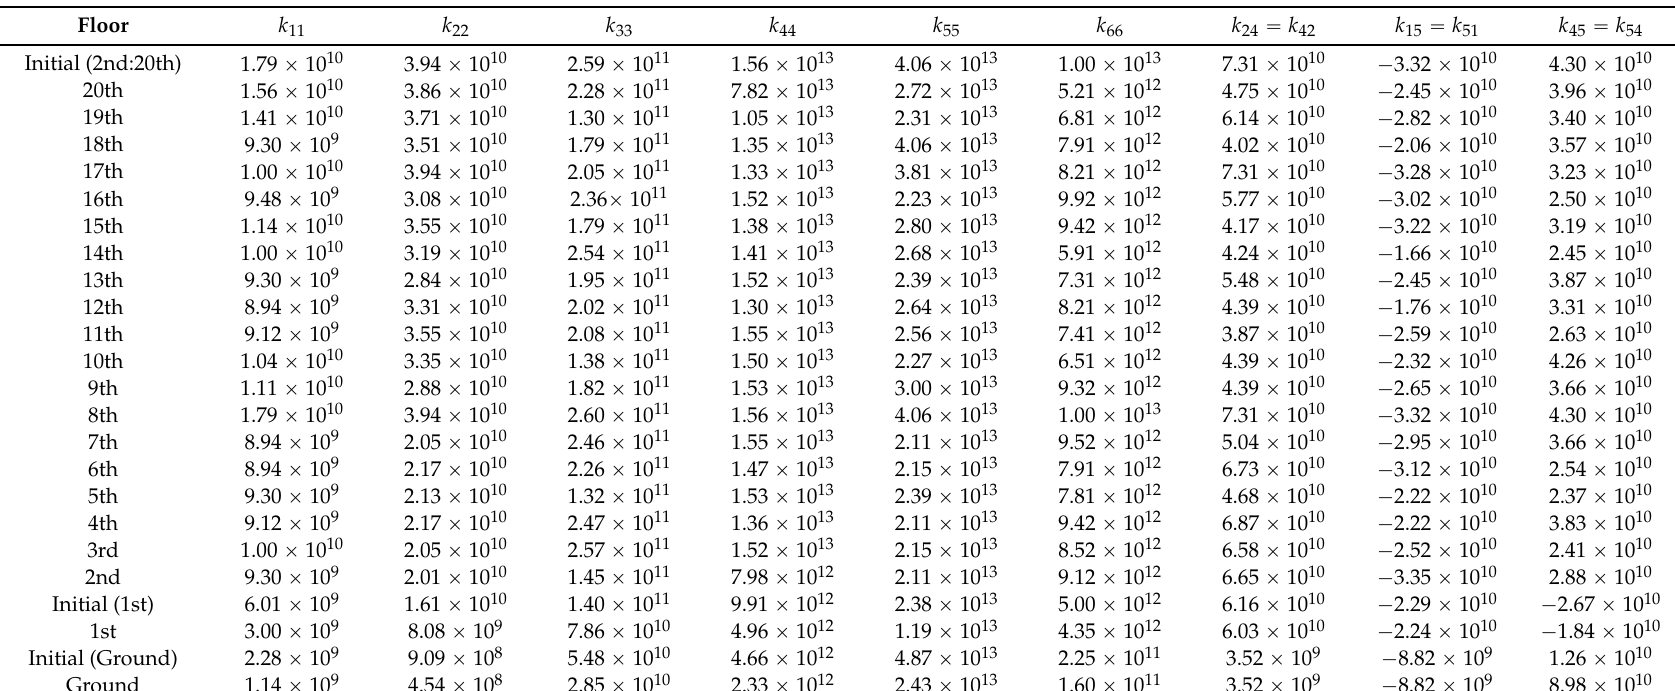
Table 6. Stiffness properties of the Green building: unit